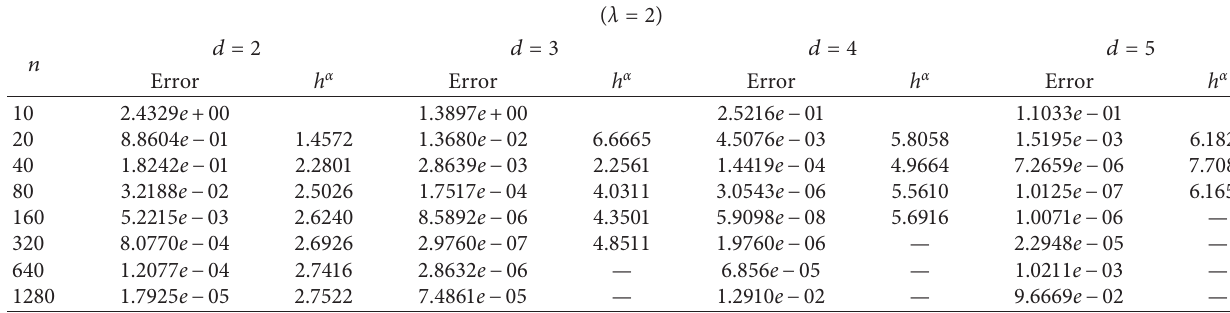
Table 3: Errors and convergence rate of the equidistant nodes with different λ . ( d � 4 )